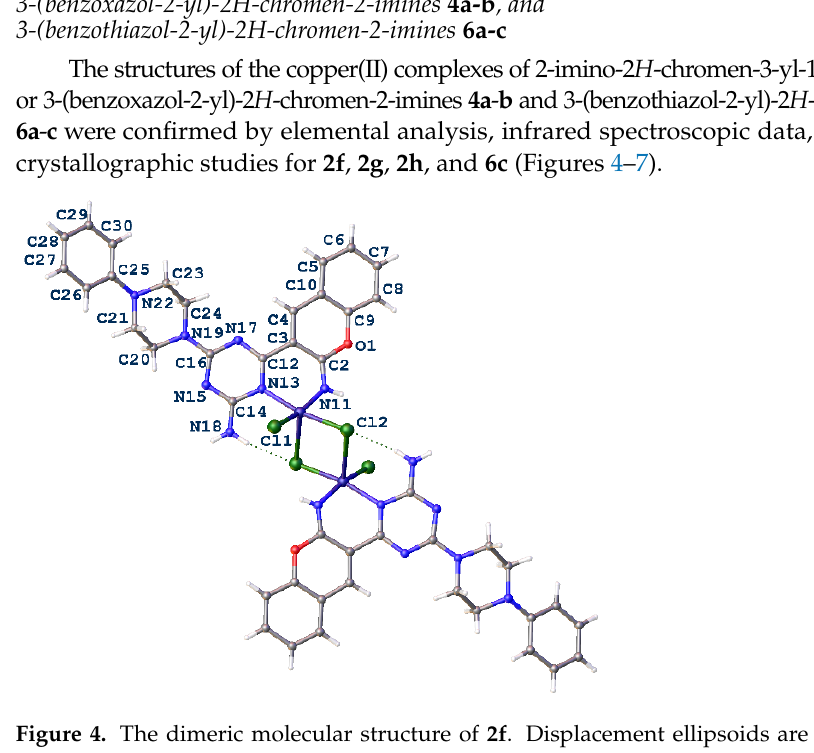
. Figure 5. Molecular structure of 2g . Displacement ellipsoids are shown at the 50% probability level.